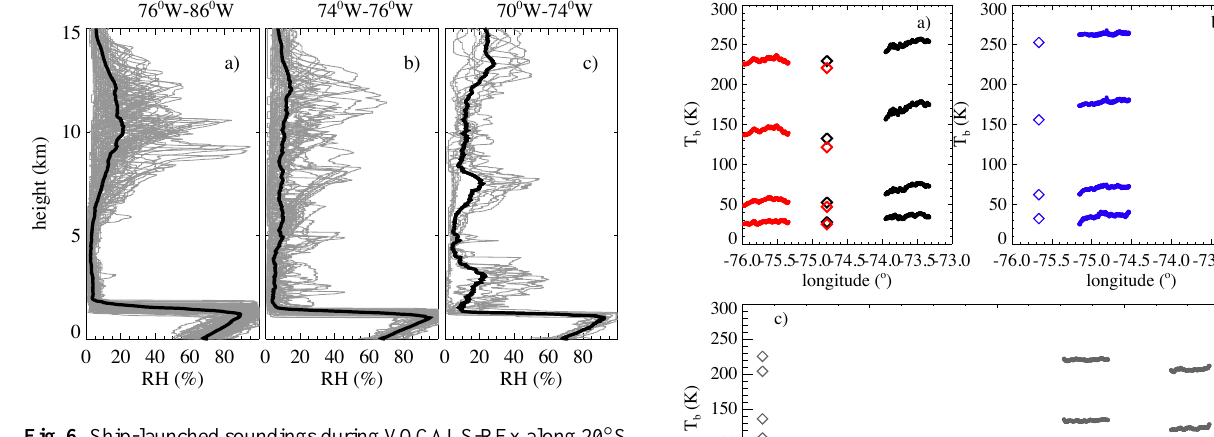
0.2 mm respectively (Fig. 7a). The longitudinal T b